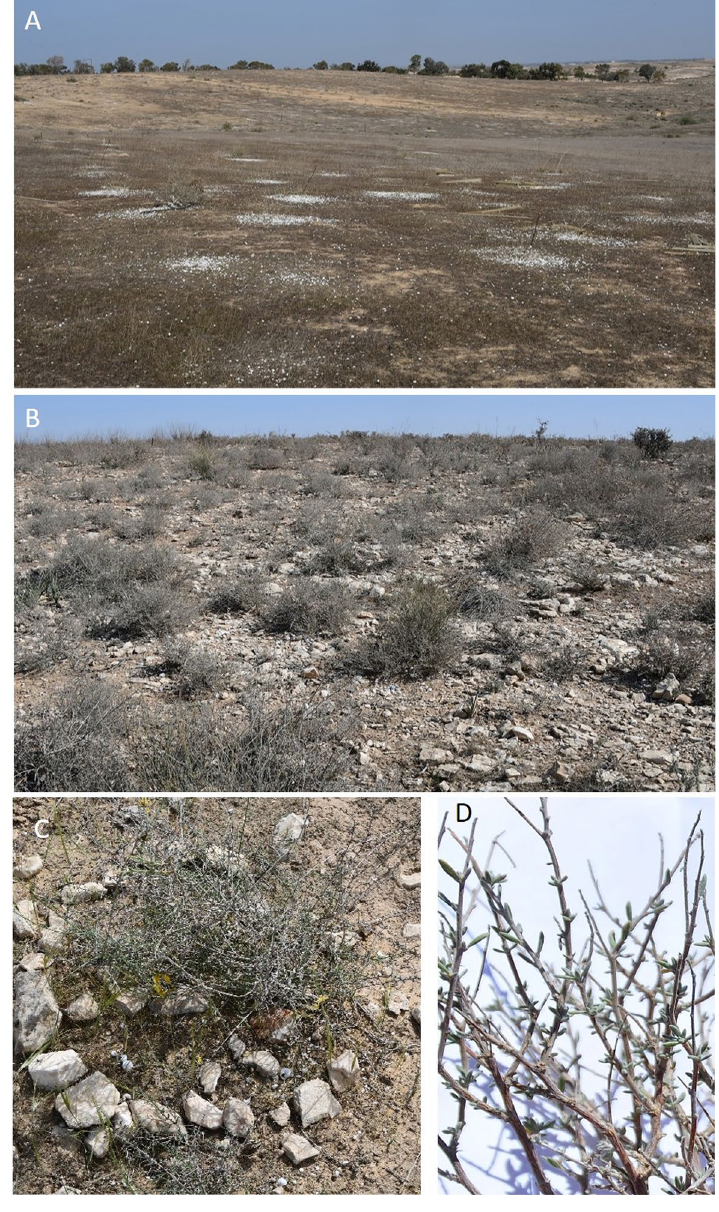
Figure 2. A view of a homogeneous ( A ) and a heterogeneous ( B ) hillslopes. In the homogeneous hillslopes, the white spots are piles of snails in the vicinity of dead shrubs. The piles indicate the location of dead shrubs. At the same time, most of the shrubs in the heterogeneous hillslope are alive, and survived the prolonged drought of 2008–2009. N. mucronata during spring season ( C ). A detail of winter leaves ( D ). Photos courtesy of Prof. Hezi